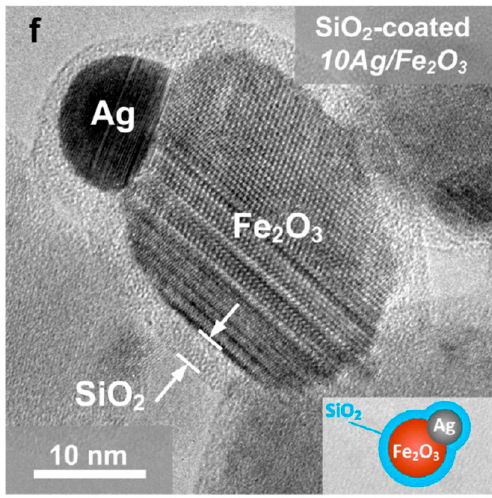
Figure 7. HR-TEM image of silica coated Ag-Fe 2 O 3 dumbbell synthesised by flame spray pyrolysis Reprinted with permission from [56]. Copyright ACS, 2013.